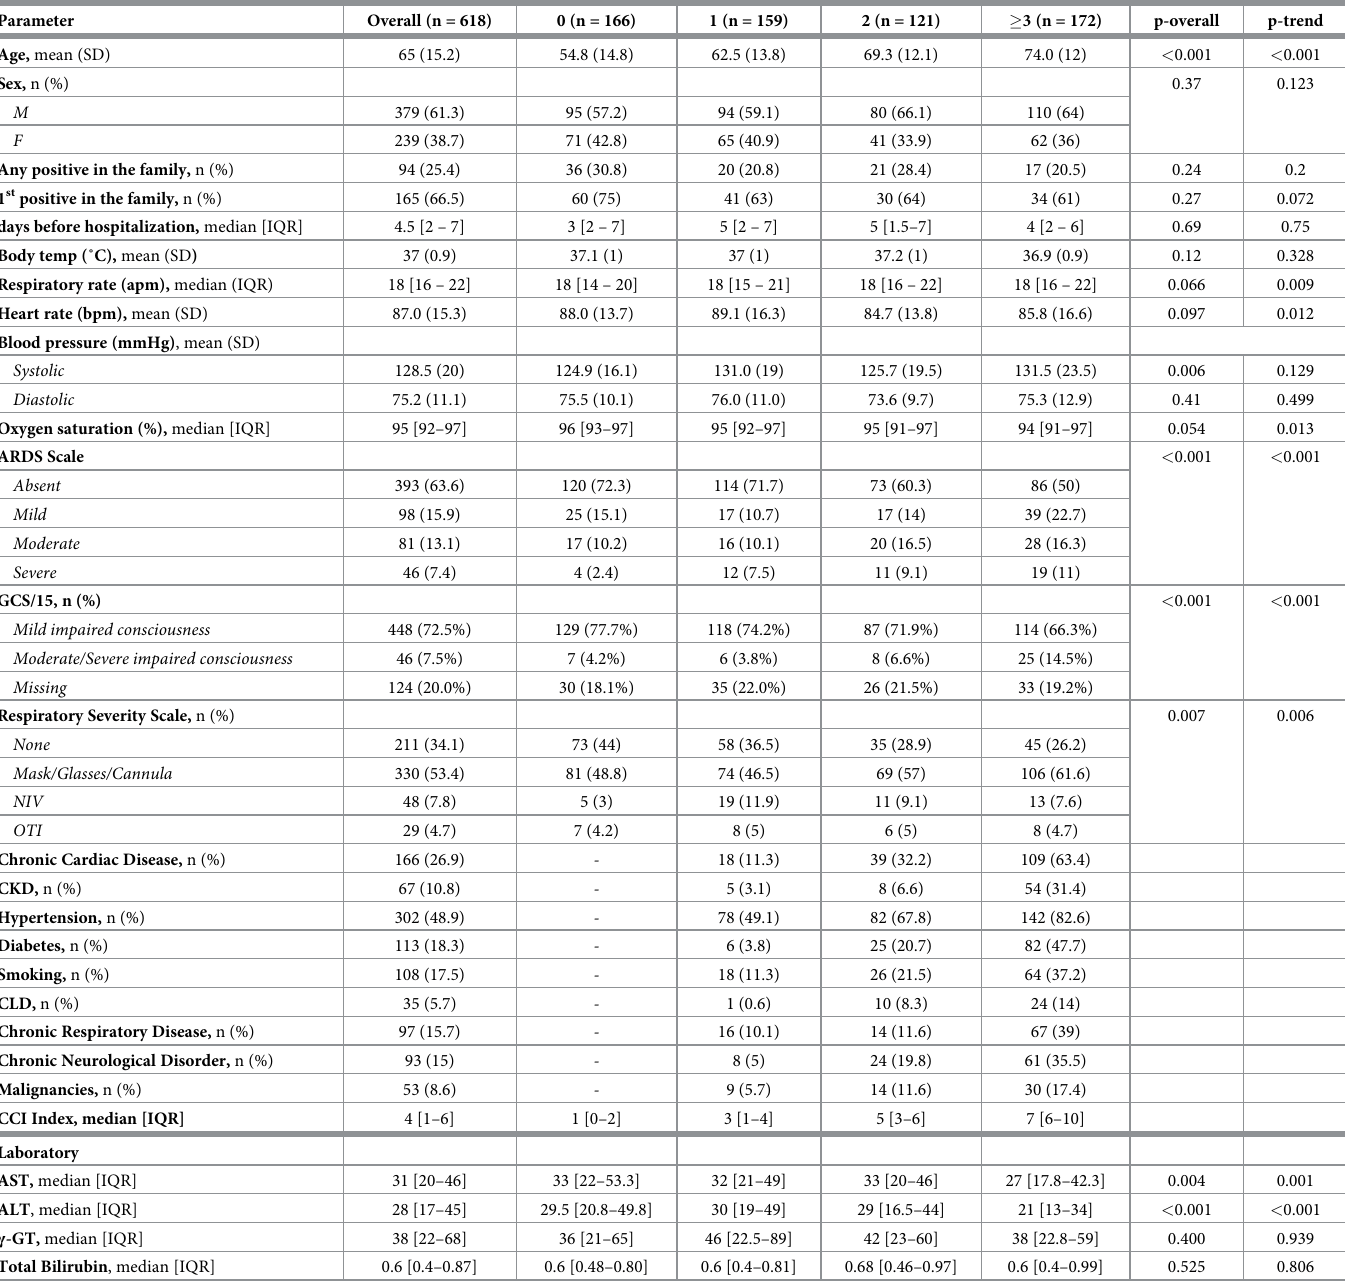
Table 1. Baseline characteristics of the study population, both overall and according to the number of preexisting